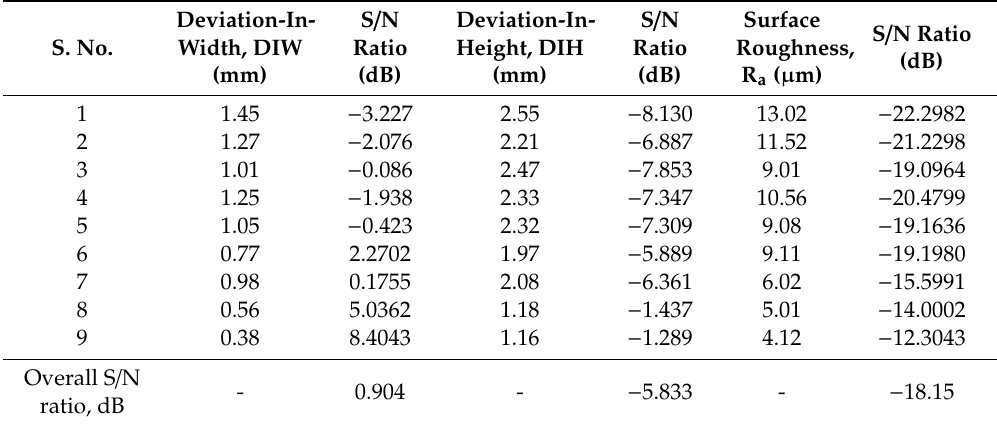
Table 4. Observed results for deviation-in-width (DIW), deviation-in-height (DIH), and surface roughness